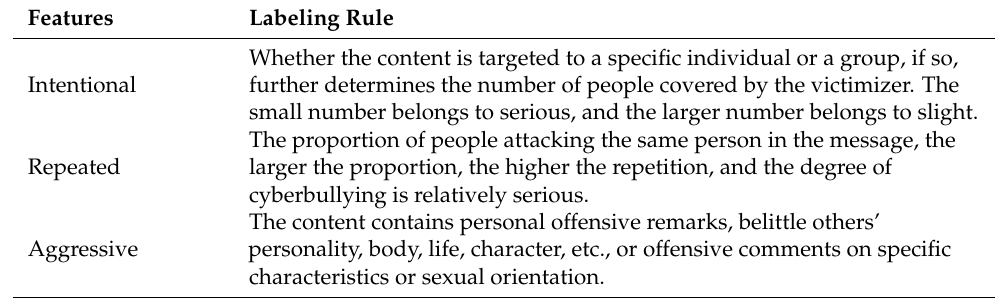
Table 1. Labeling standards for